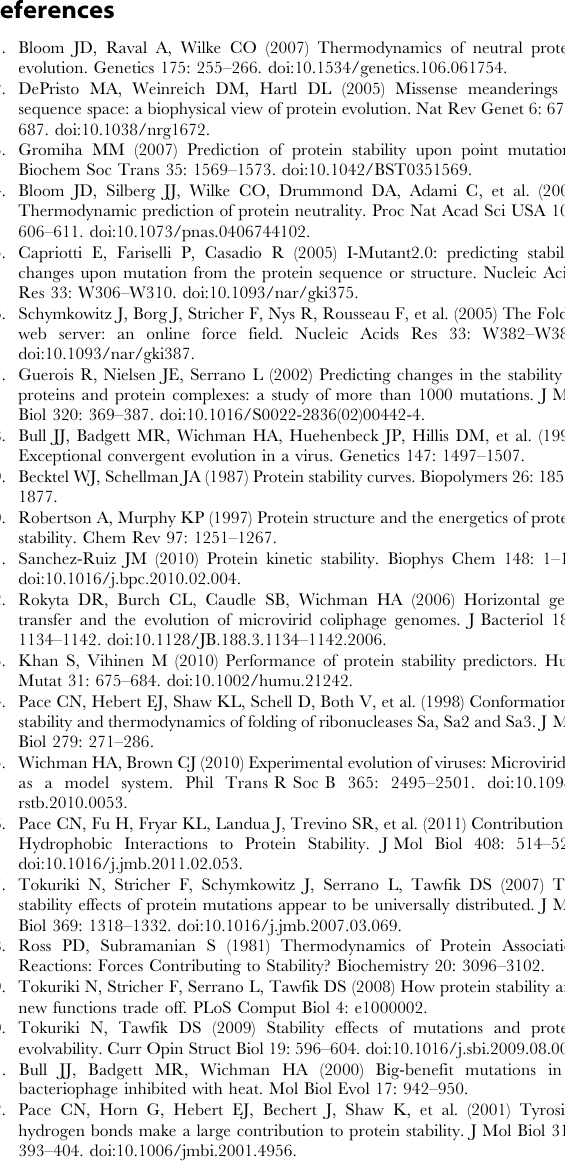
Table S1 FoldX estimates of DD G fold and DD G bind for